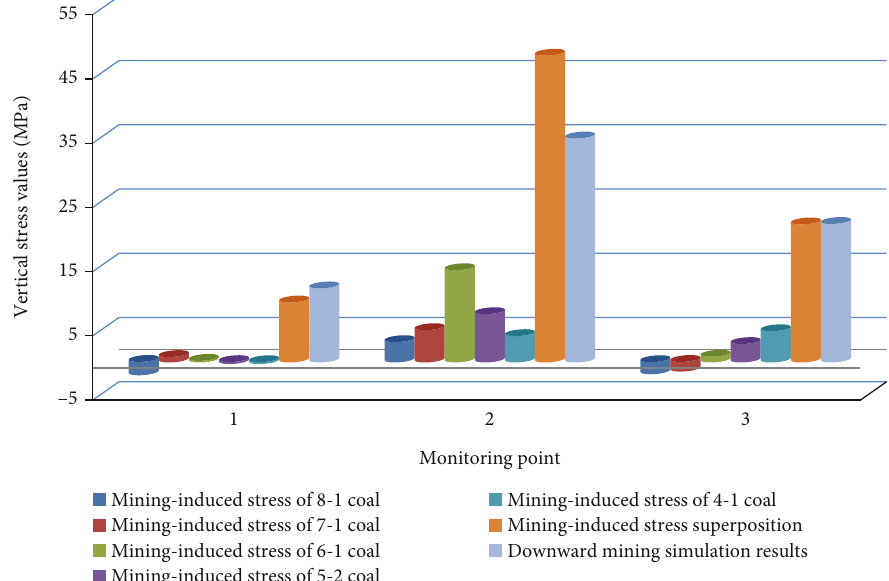
Figure 12: Analysis of the interactive e ff ect of mining-induced stress in multiseam on the vertical stress in three monitoring